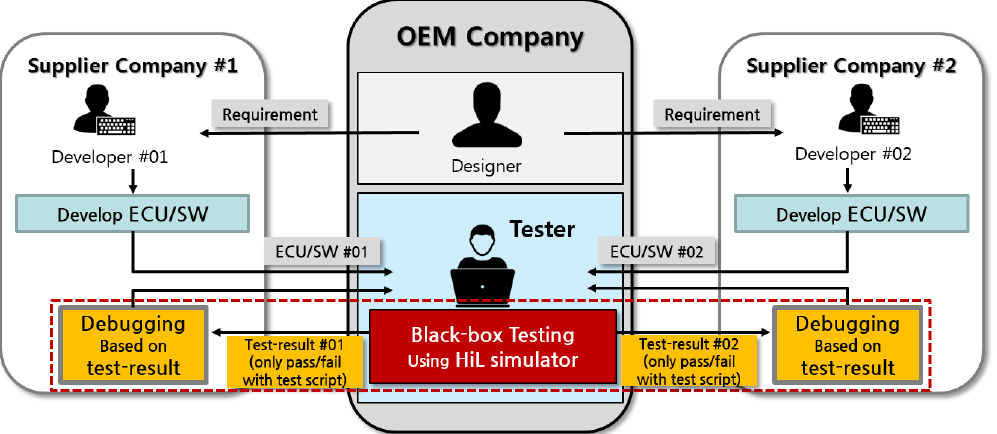
Figure 1. The process of developing automotive Electronic Control Unit (ECU) software.